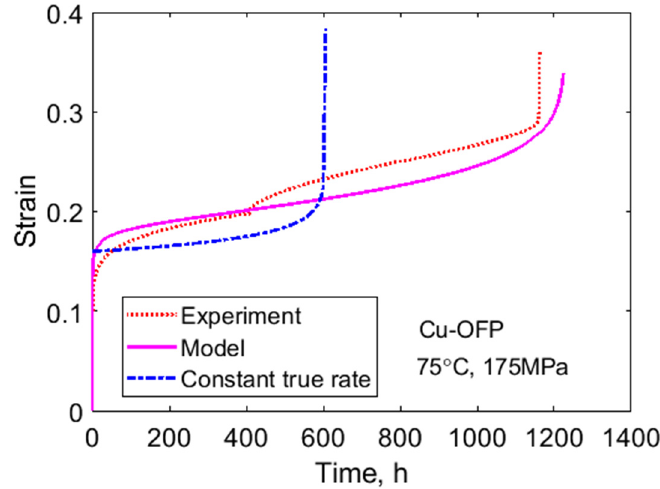
Figure 13. Creep strain versus time for Cu-OFP at 75 °C and 175 MPa. Forged material. The model curve is derived with Equation (28). The cusp on the experimental curve is due to a reloading of the creep machine. Redrawn with permission from ref. [17]. Copyright 2022 Elsevier.